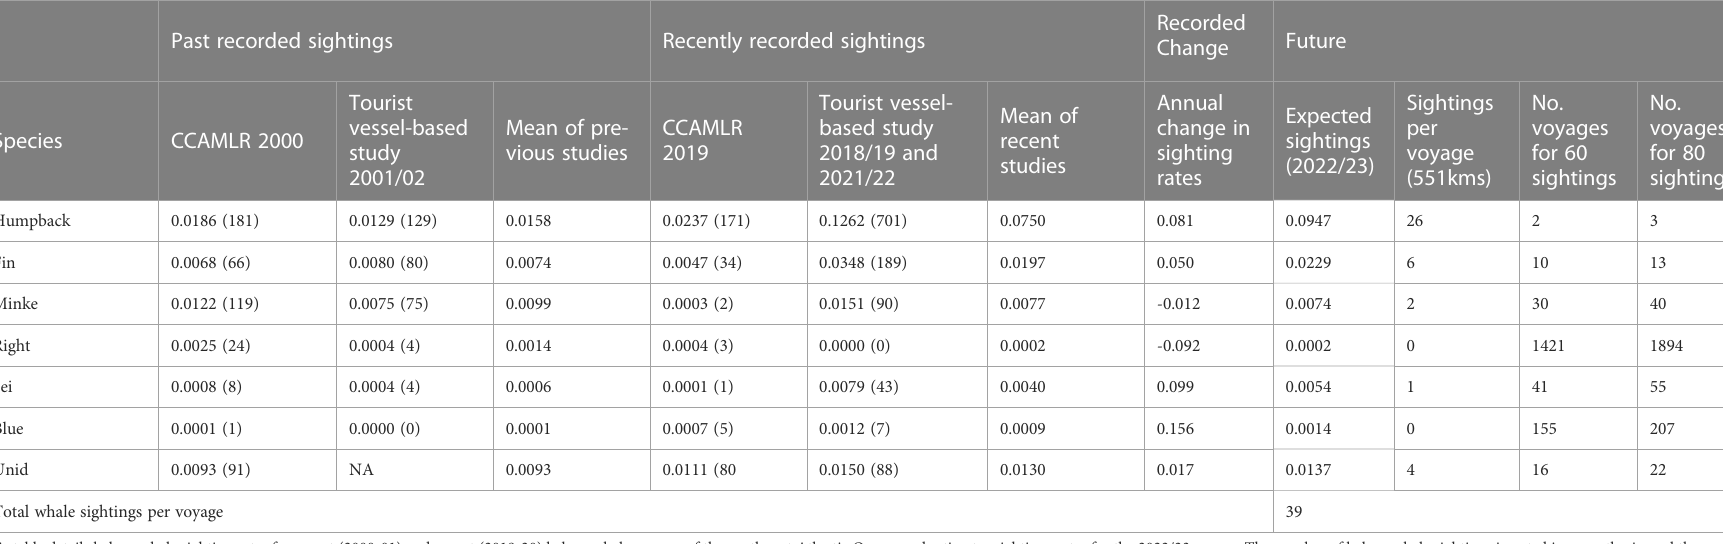
TABLE 3 Predicted baleen whale sighting rates (whale sightings/kilometer of realized survey effort ) for the 2022/23 season calculated from past and recent sighting